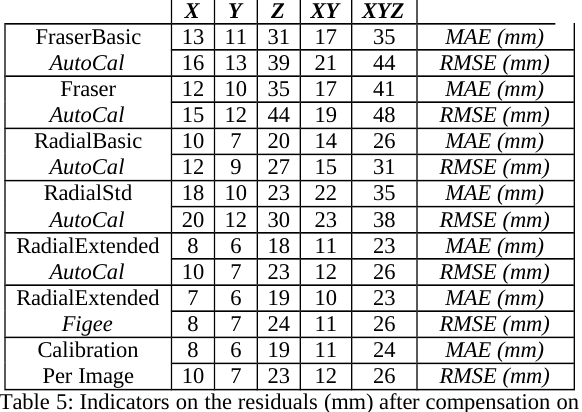
Table 5: Indicators on the residuals (mm) after compensation on the GCP